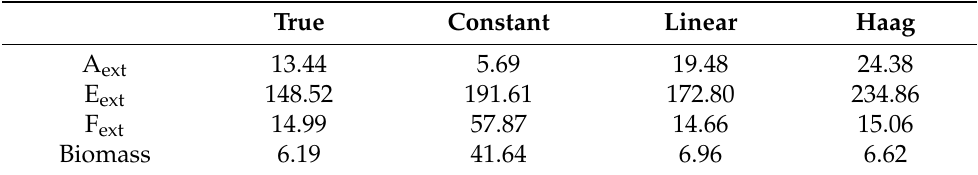
Table 2. Absolute values of the absolute tracking errors, i.e., difference between state and set